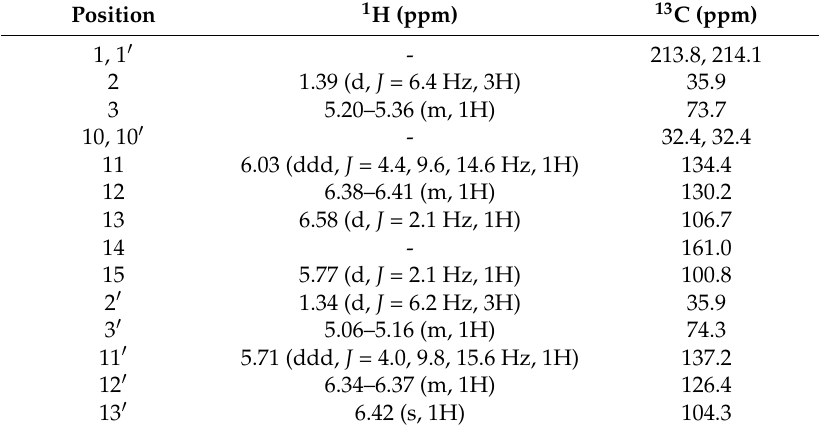
Table 1. 1 H-NMR and 13 C-NMR data of 1 (400/100 MHz, Methanol- d 4 ).